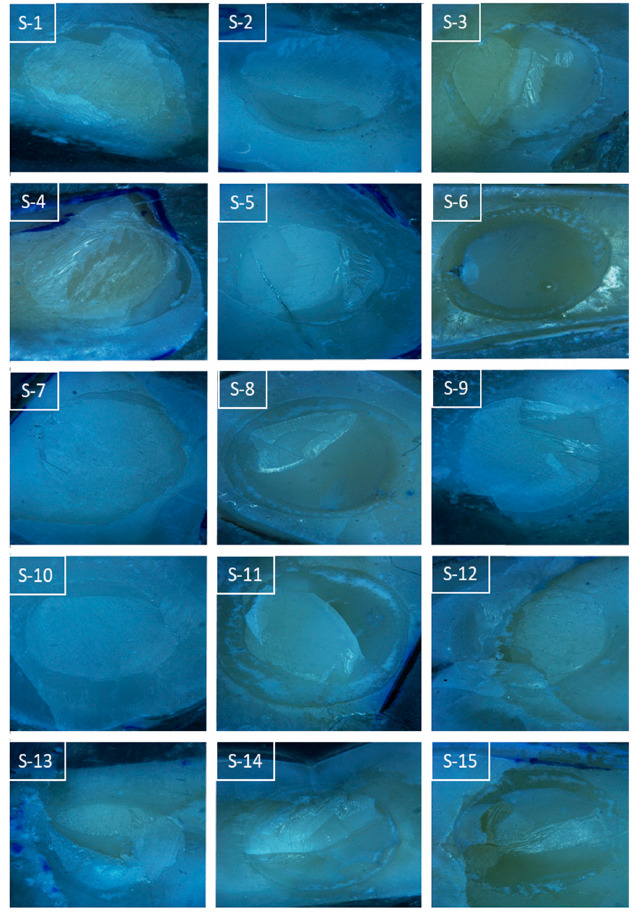
Figure 5. Microscopic analysis of the modes of failure n = 15 (Group II).